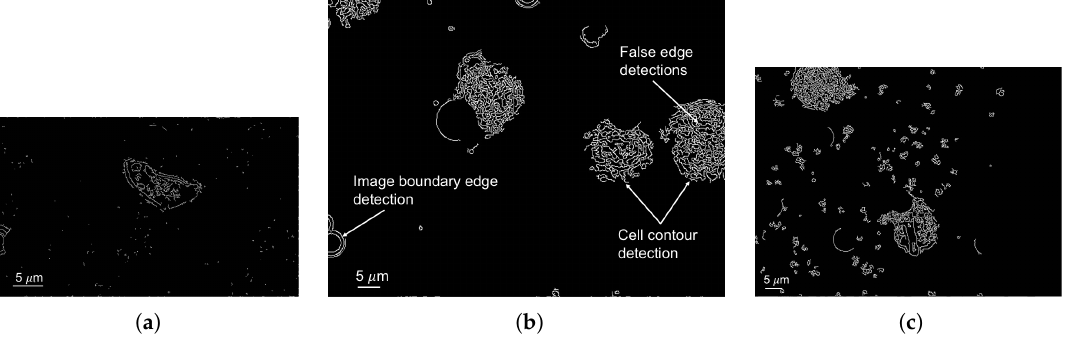
( x , y ) ; ( b ) I sw ( x , y ) ; ( c ) I sm ( x , y ) . je je je